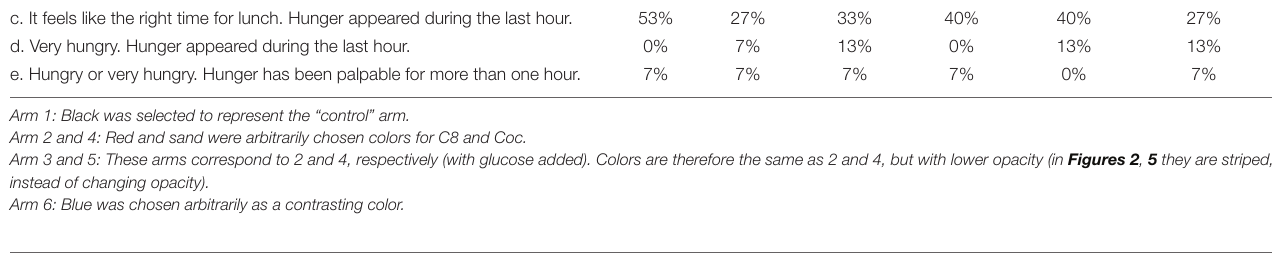
TABLE 5 | Self-reported tolerance, assessed by a questionnaire directly after T240 (minutes). “Did you experience any inconvenience (e.g., nausea, upset stomach), which you attribute to the beverage you were served today?”